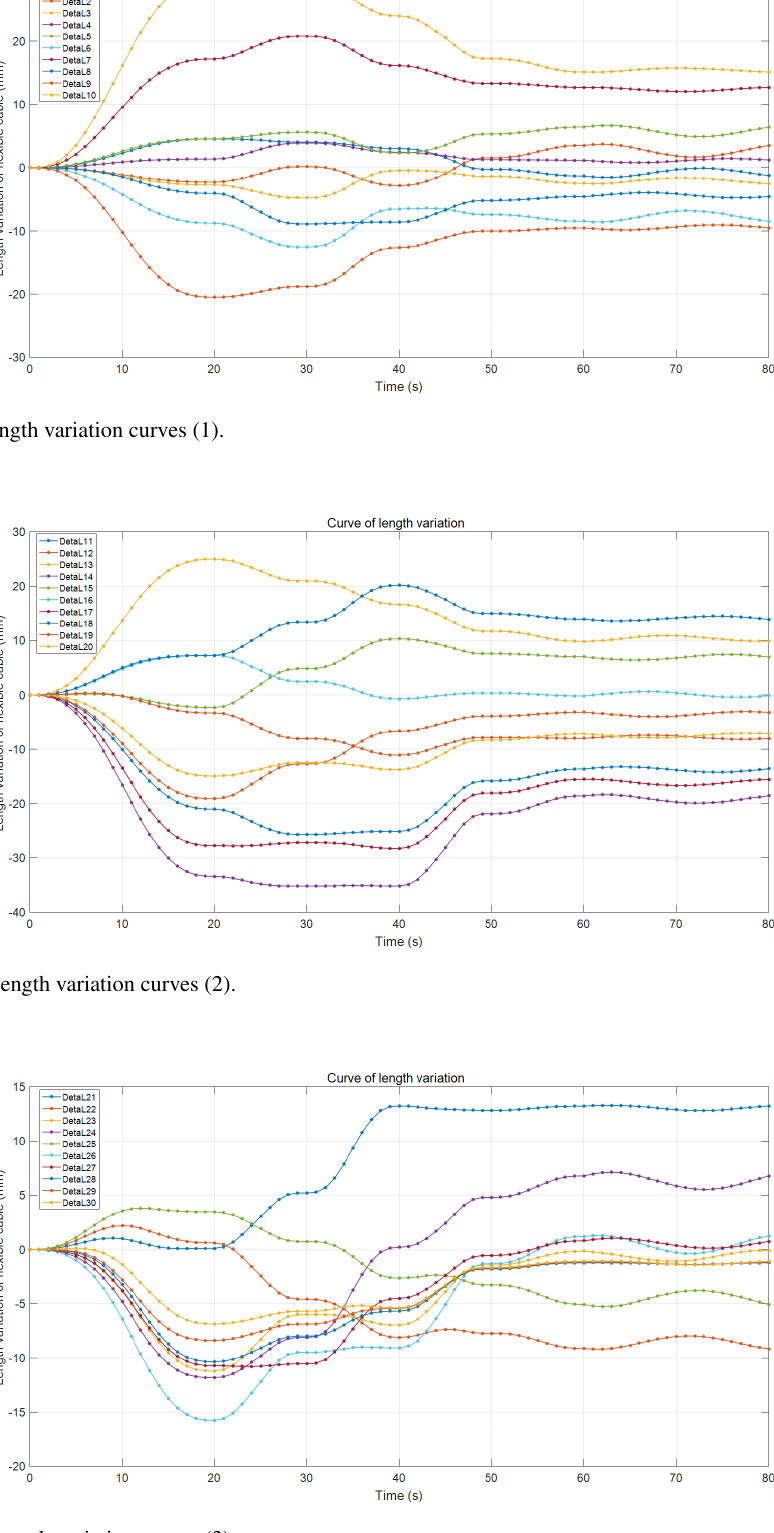
Mech. Sci., 12, 1017–1026,